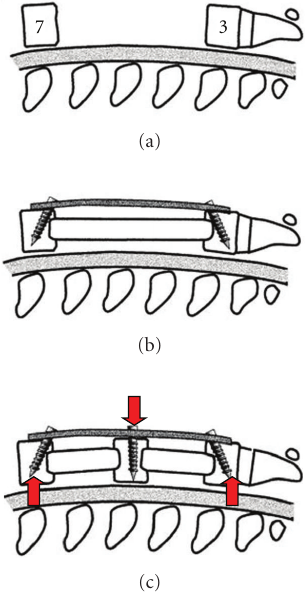
Figure 4: Ventral corpectomy approach with one large strut grafts and two points of screw fixation for kyphotic deformity